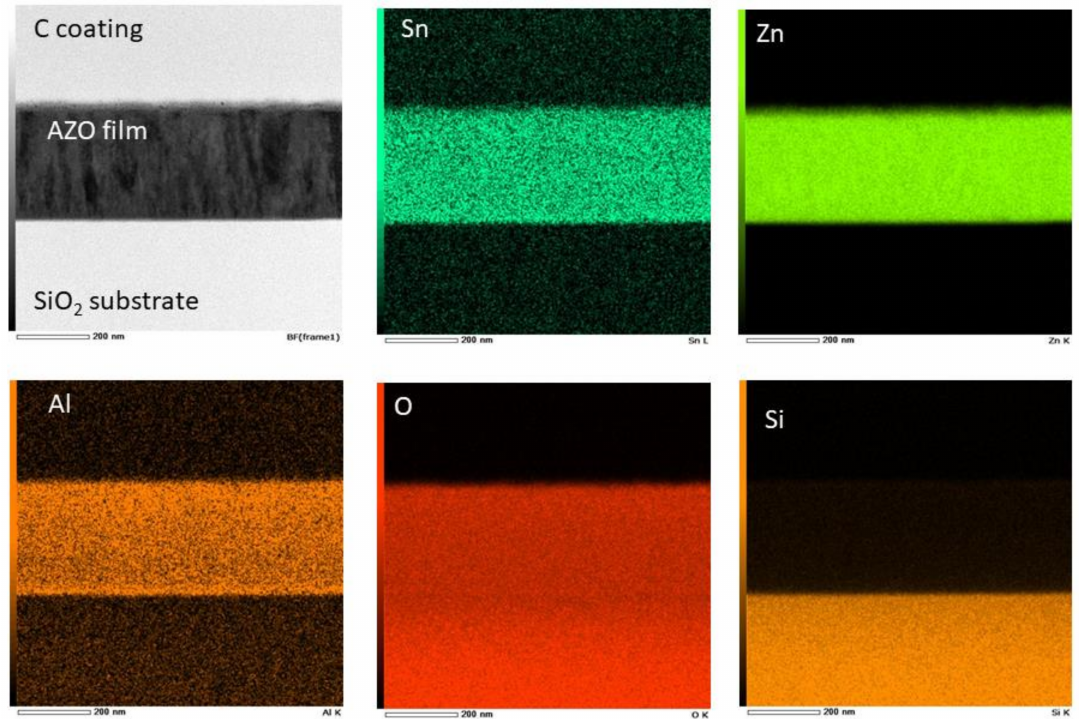
Figure 4. TEM-EDS (energy-dispersive spectroscopy) elemental maps of the AZO + SnO 2 2 wt.% silica thin film (AZO_2S) for the atoms Sn, Zn, Al, O and